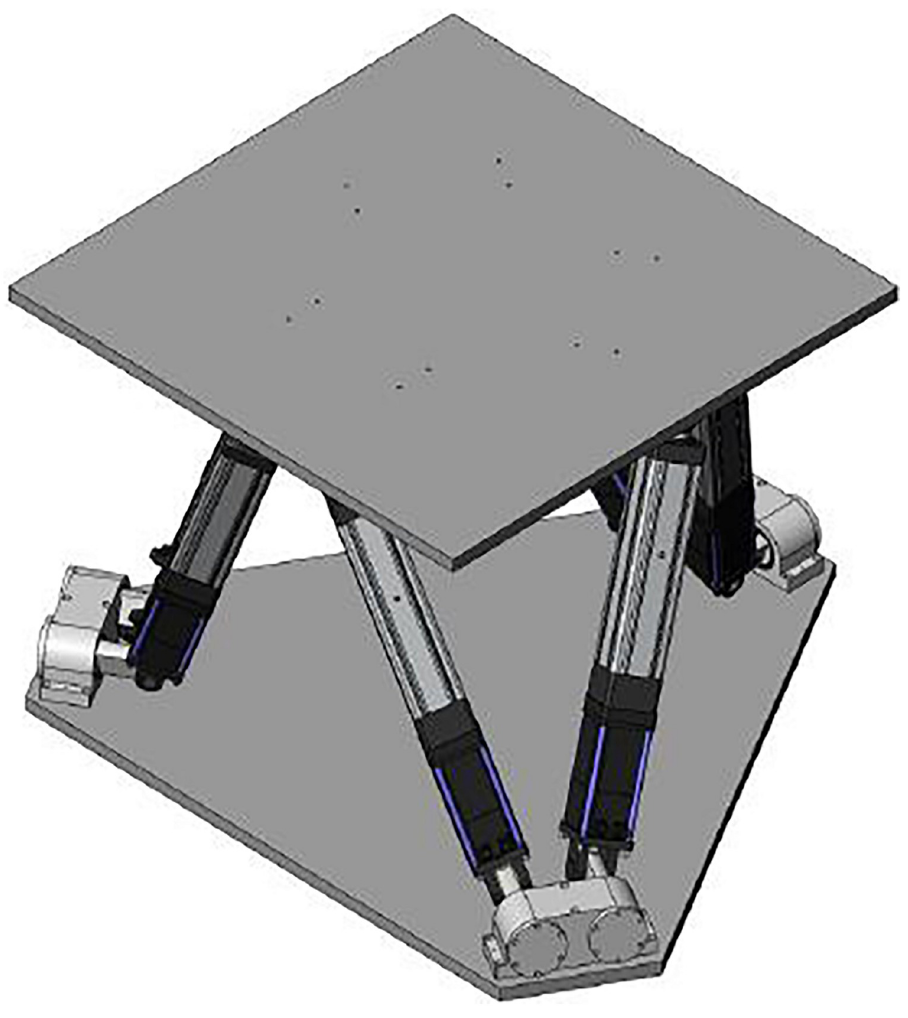
Fig 4. Vibration